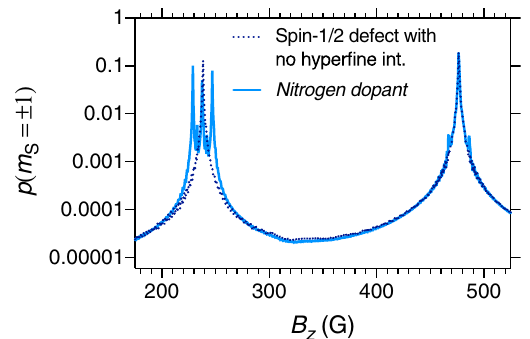
Fig. 3 Population of the m S = ±1 spin states for the case of spin-1/2 defect with strong hyper fi ne interaction. Solid light blue line shows the population variation of the hh divacancy spin states due to substitutional nitrogen shallow donor. Dotted dark blue depicts population variation due to spin-1/2 electron spin defects without hyper fi ne coupling. Hyper fi ne interaction leads to a splitting of the center peak into three peaks at B GSLAC /2 as well as to the appearance of two satellite peaks next to the GSLAC